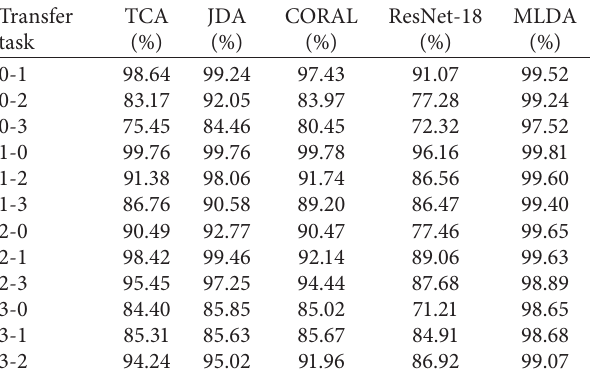
Figure 8: Classification results of MLDA. Table 5: Experimental results of different